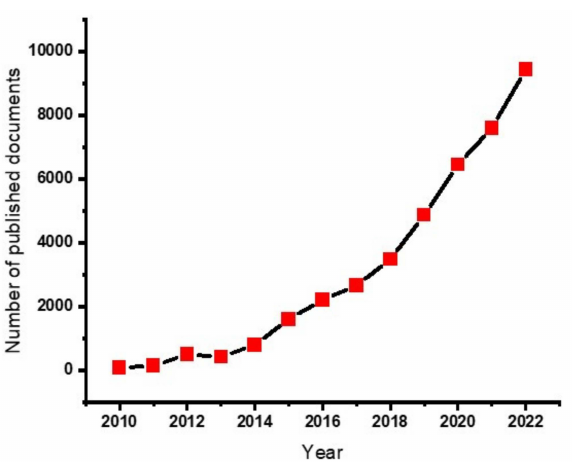
Figure 1. Number of published papers on the https://app.dimensions.ai/ data base with the search of “hydrogels for supercapacitor” (the data is accessed on 20 January